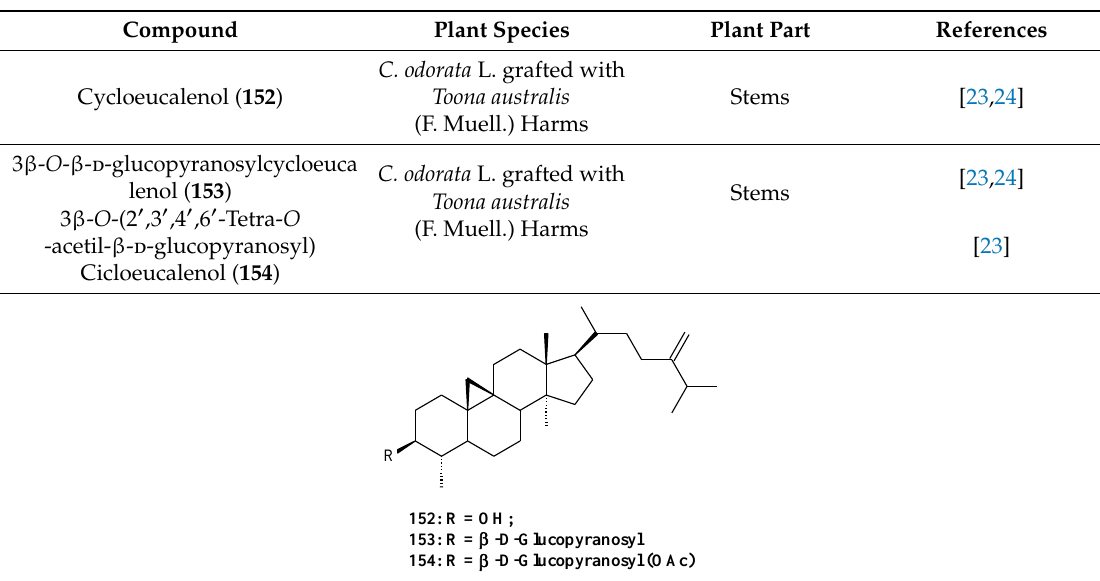
Table 7. Cycloartanes isolated from the genus Cedrela (1960–2020).